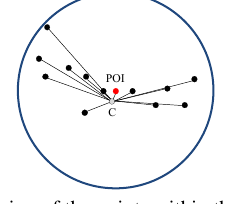
Figure 2: Dispersion of the points within the established 3D neighbourhood relative to their